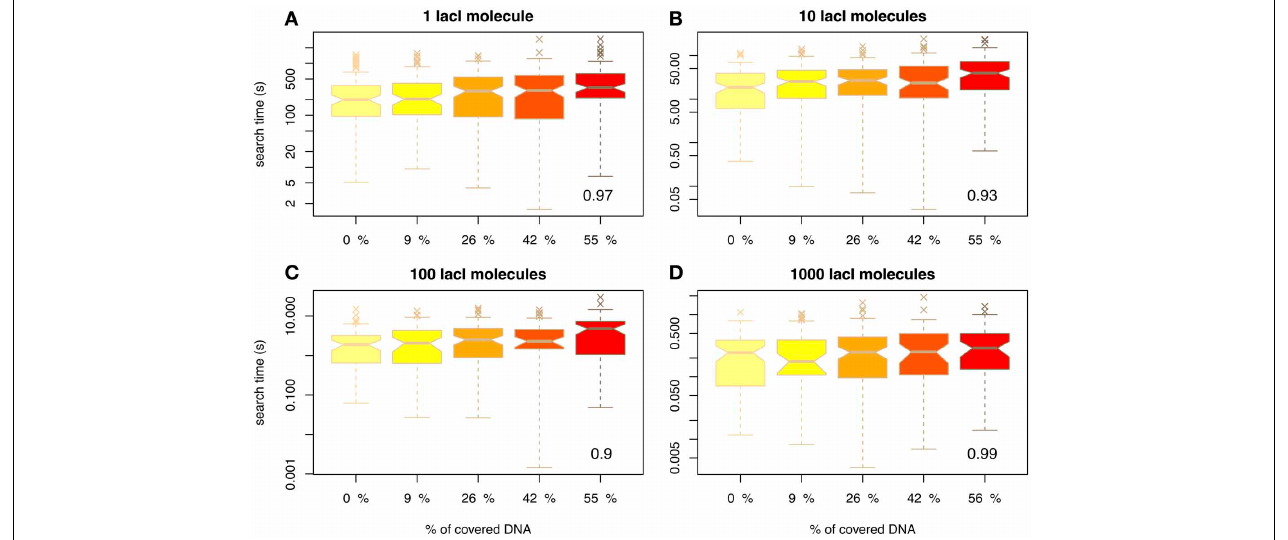
FIGURE 1 | The average time for the TF to reach the target site (measured in seconds) as a function of DNA crowding in the case of mobile obstacles. Note the differences between scales of the y-axis, e.g. for 1 lacI molecule it takes in the range of tens of minutes to locate the target site, while for 100 copies the search time is in the range of seconds. The number in the inset represents the Pearson coefficient of correlation between crowding and the mean of the search time. The values indicate the crowding is highly correlated with the search time, in the sense that higher crowding on the DNA leads to higher search times. We used notched boxplots to represent the data, where: (1) the line in the box represents the median, (2) 50% of the data (the interquartile range IQR ) occurs between the